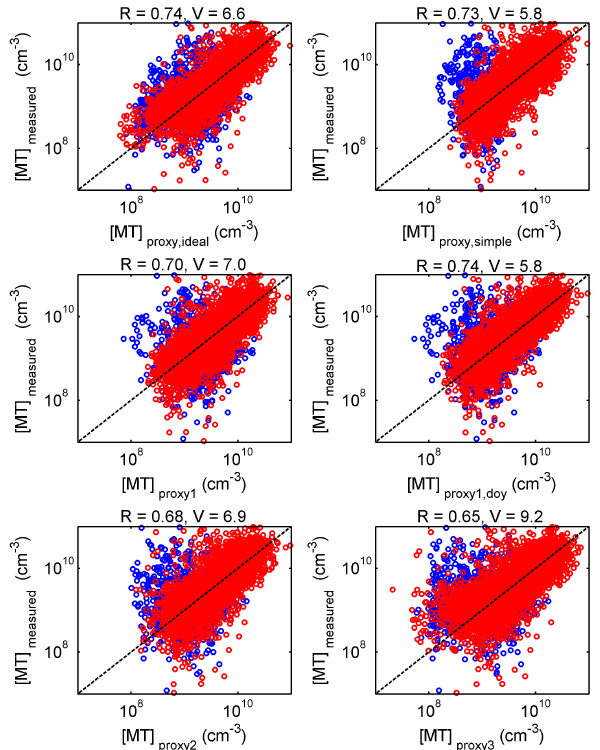
Figure 5. Correlations between the measured monoterpene concen- tration and the concentrations predicted by different proxies. The blue circles show all data and red circles data for March–November. The dotted line is the 1 : 1 line. The correlation coefficients ( R ) and V 90 / 10 values are presented in the